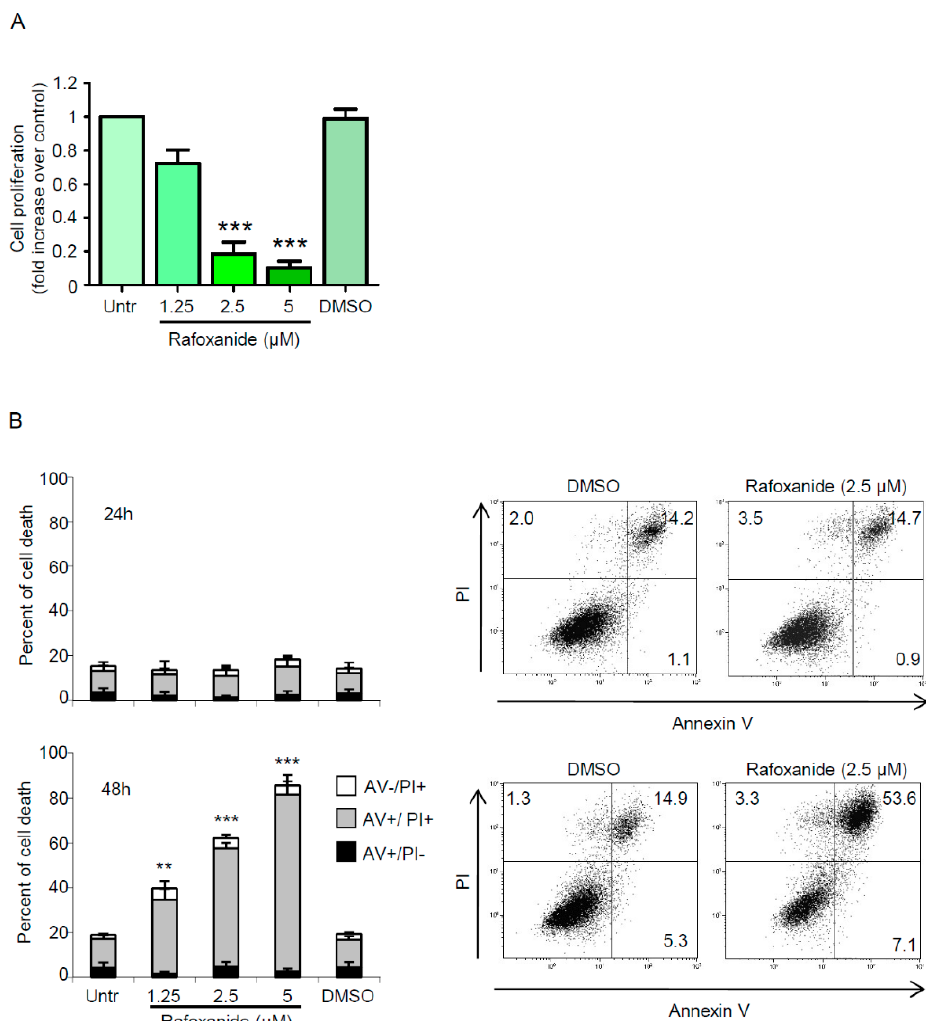
Figure 4. Rafoxanide inhibits proliferation and induces cell death in the murine colon adenocarcinoma cell line CT26. ( A ) CT26 cells were either left untreated (Untr) or treated with rafoxanide or DMSO (vehicle) for 24 h. Cell growth was assessed through a BrdU assay. Data indicate mean ± SEM of three experiments. Data were analyzed using one-way analysis of variance (ANOVA) followed by Dunnett’s post hoc test. DMSO vs. rafoxanide-treated cells: *** p < 0.001. ( B ) Histograms showing the percentage of cell death in CT26 cells either left untreated (Untr) or treated with either DMSO or rafoxanide for 24 h (upper panel) and 48 h (lower panel). Cell death was assessed by flow-cytometry analysis of Annexin V (AV) and / or propidium iodide (PI)-positive cells. Data are expressed as mean ± SD of three experiments. Data were analyzed using ANOVA followed by Dunnett’s post hoc test. DMSO vs. rafoxanide-treated cells, ** p < 0.01, *** p < 0.001. Right insets. Representative dot-plots showing the percentages of AV- and / or PI-positive cells treated with either DMSO or rafoxanide for 24 h (upper panel) and 48 h (lower panel).